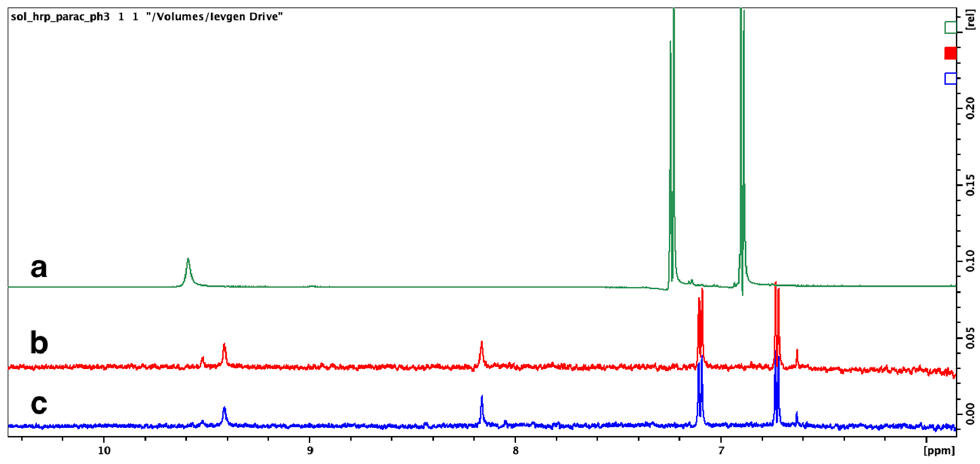
Figure 8. NMR spectra initial paracetamol ( a ), paracetamol after interaction with sol–gel HRP ( b ), and LiP ( c ) composites at pH = 3.